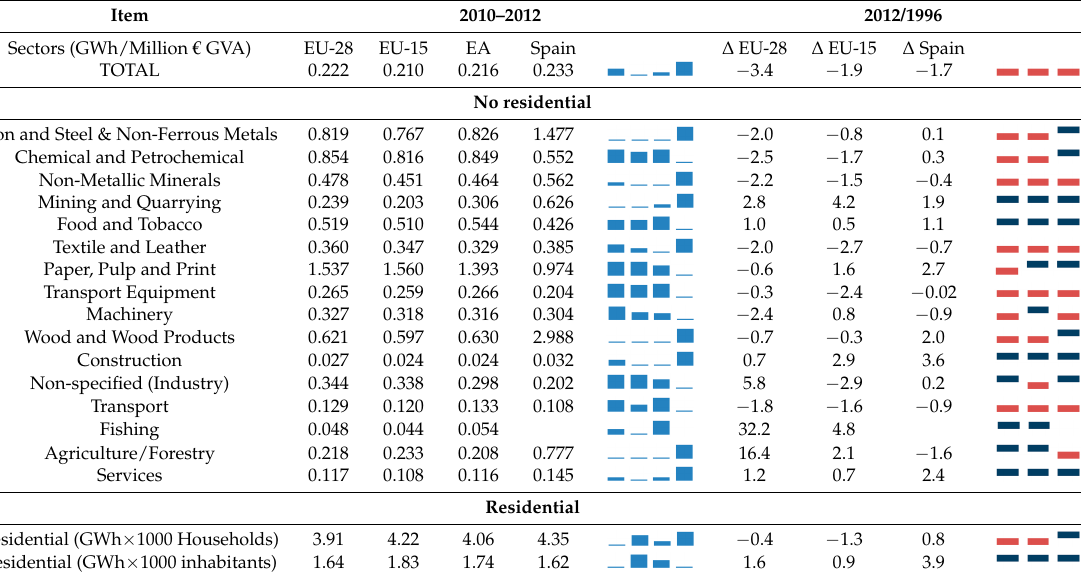
Source: Own calculations with Eurostat data.